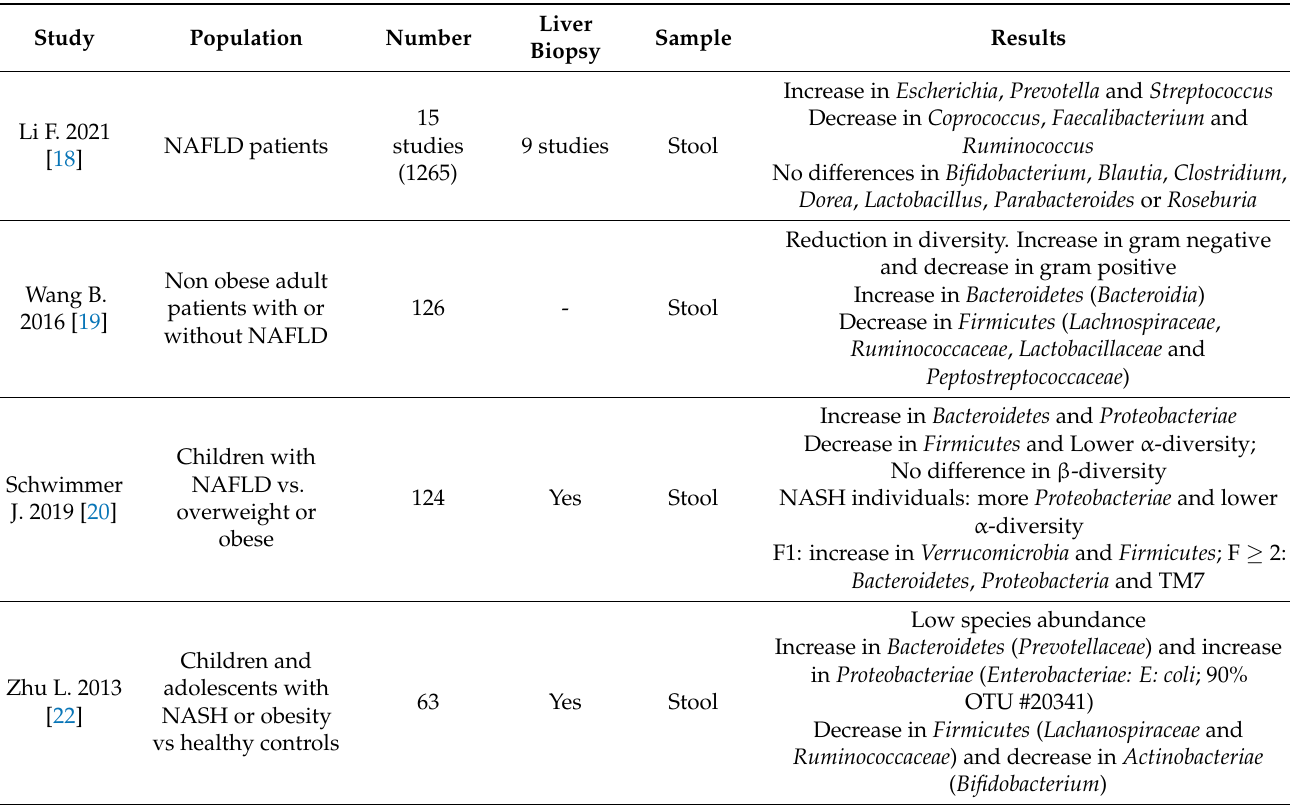
Table 1. Summary of studies about dysbiosis observed in patients with non-alcoholic fatty liver disease (NAFLD) and non-alcoholic steatohepatitis